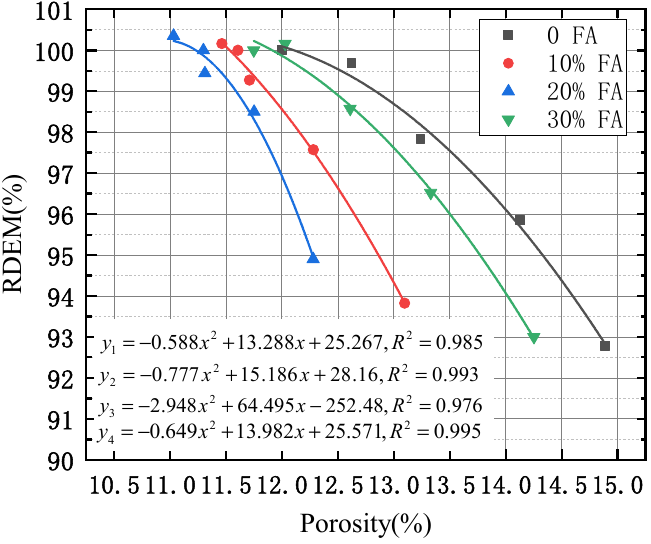
Figure 11. Relation between RDEM and porosity.